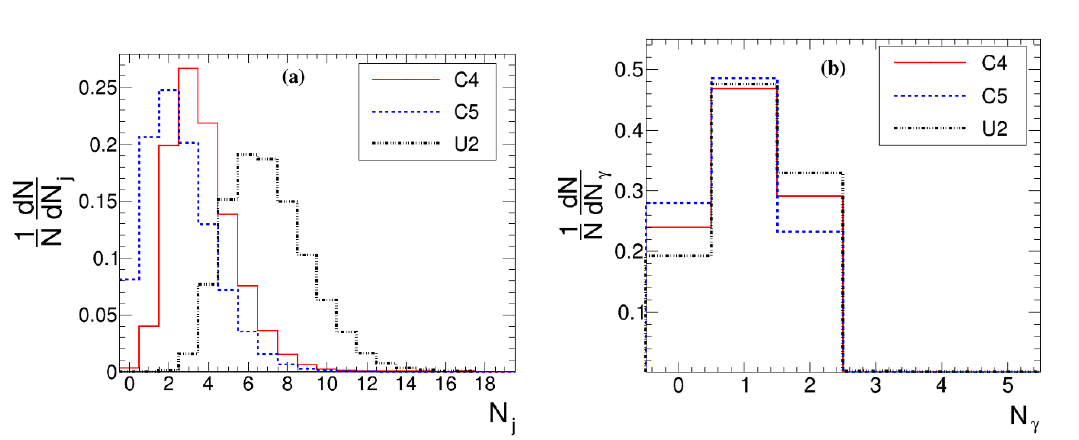
Figure 4 . Normalized distributions for jet and photon multiplicity for the benchmark points C4 , C5 and U2 representing moderately compressed, highly compressed and uncompressed scenarios respectively. Figure (a) has been prepared after implementing the selection cuts A0+A1 and (cid:12)gure (b) after A0